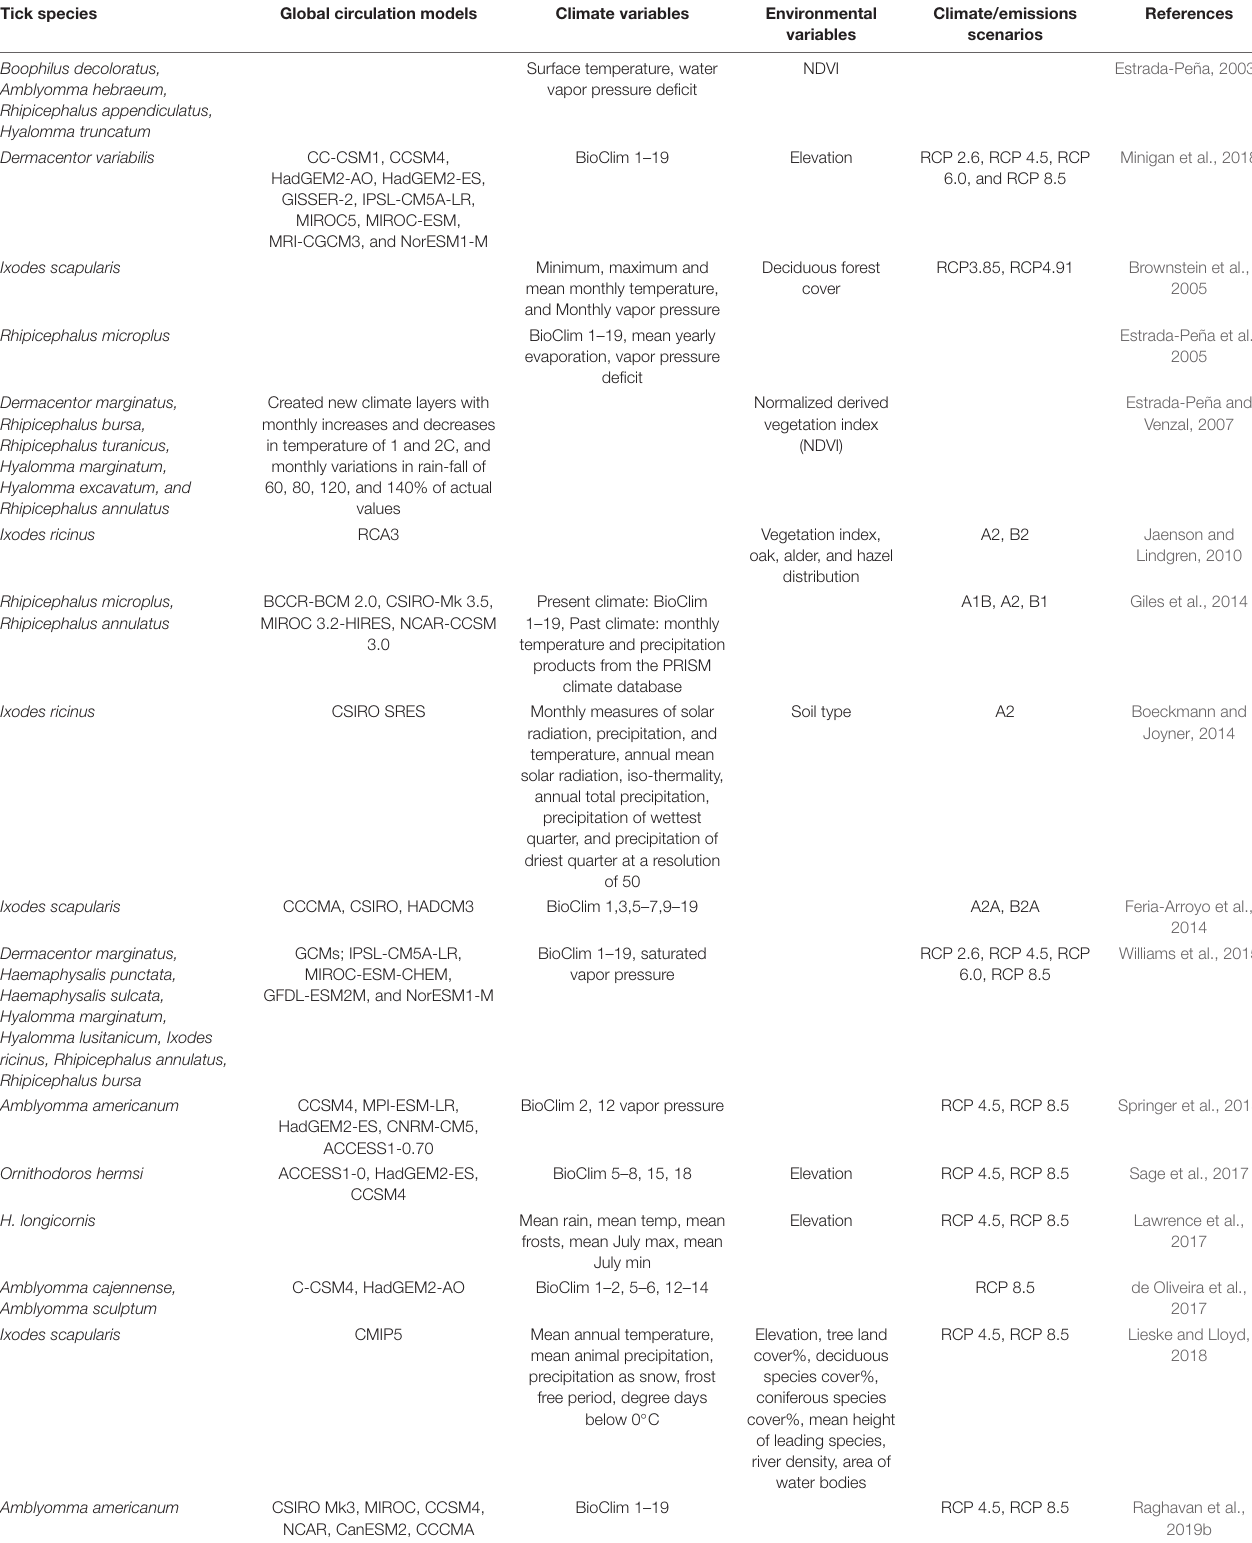
TABLE 4 | Databases used for tick occurrence, climate projections, and environmental/host species